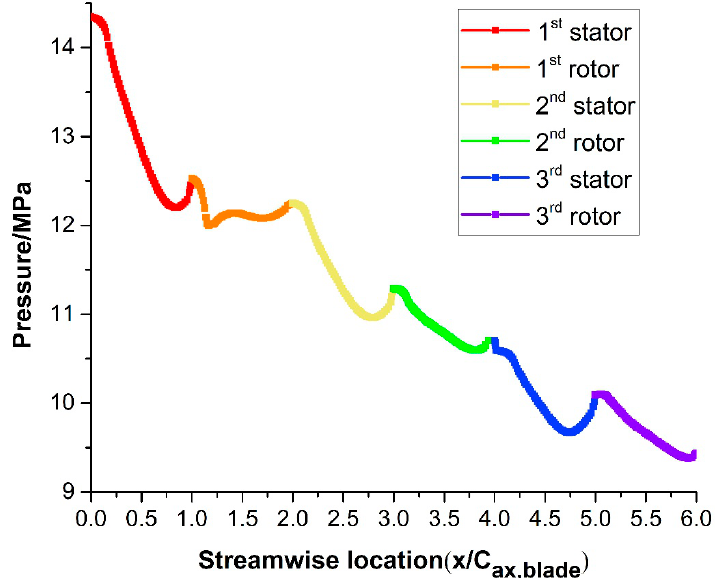
Figure 9. Pressure distribution curve of each cascade meridian plane at the 50% blade height.